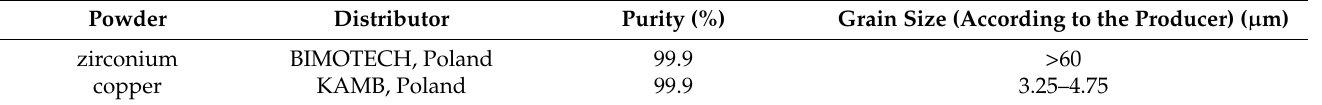
Table 1. Parameters describing zirconium and copper